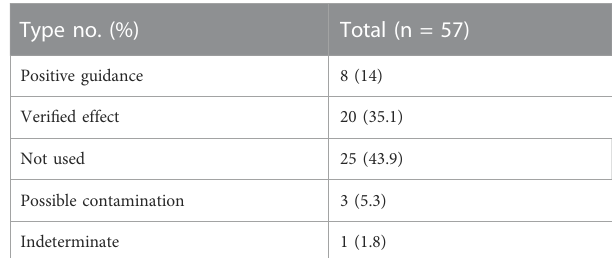
TABLE 3 Effect of positive mNGS on clinical therapeutic